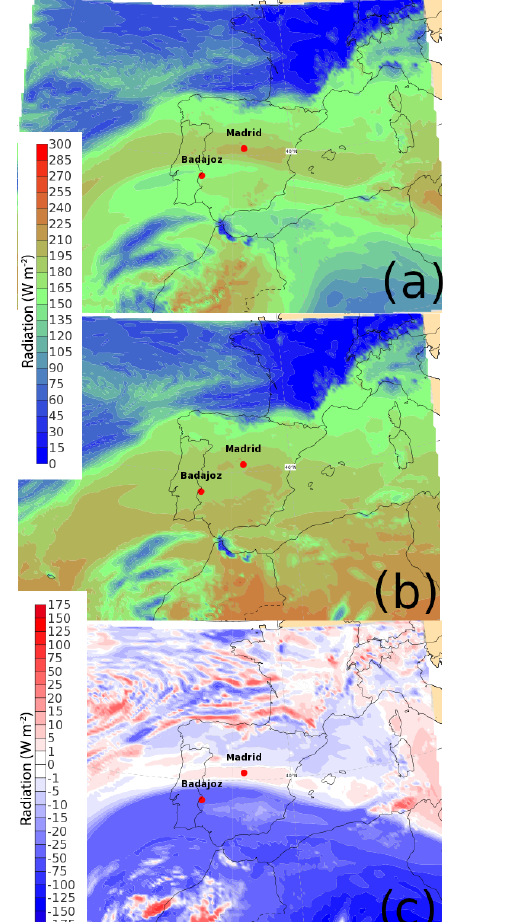
Figure 2. Dust AOD550 (dimensionless) at 12:00UTC on 21 February 2017, based on CAMS 12h forecast (a) , CAMSAOD climatology in February (b) and the default Tegen climatology in February (c) . The colour scale is given on the left column.